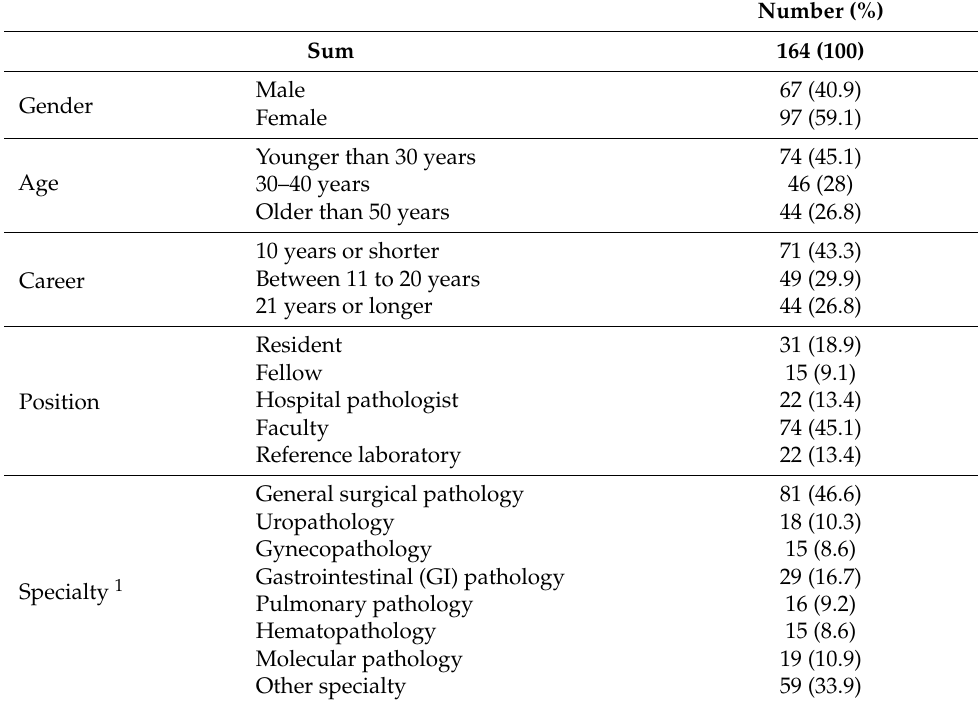
Table 1. Demographic